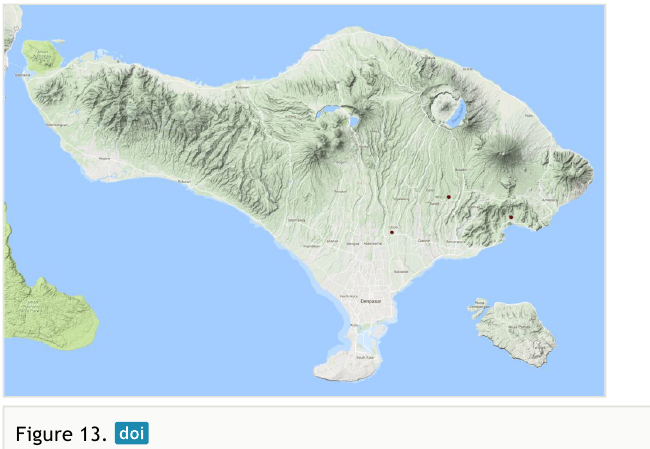
Allopachria quadripustulata Distribution in Bali.